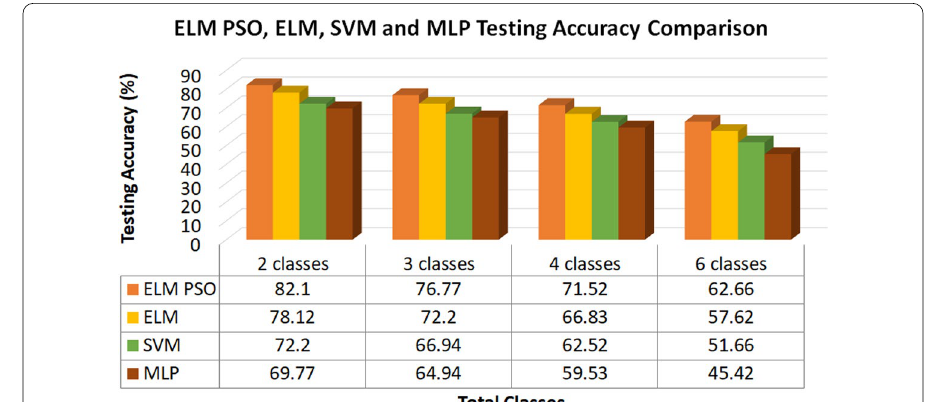
Fig. 6 The testing accuracy comparison of ELM, SVM, and ELM with PSO combination